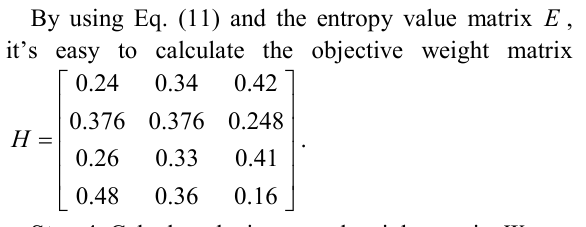
Table 1. The results of different methods using